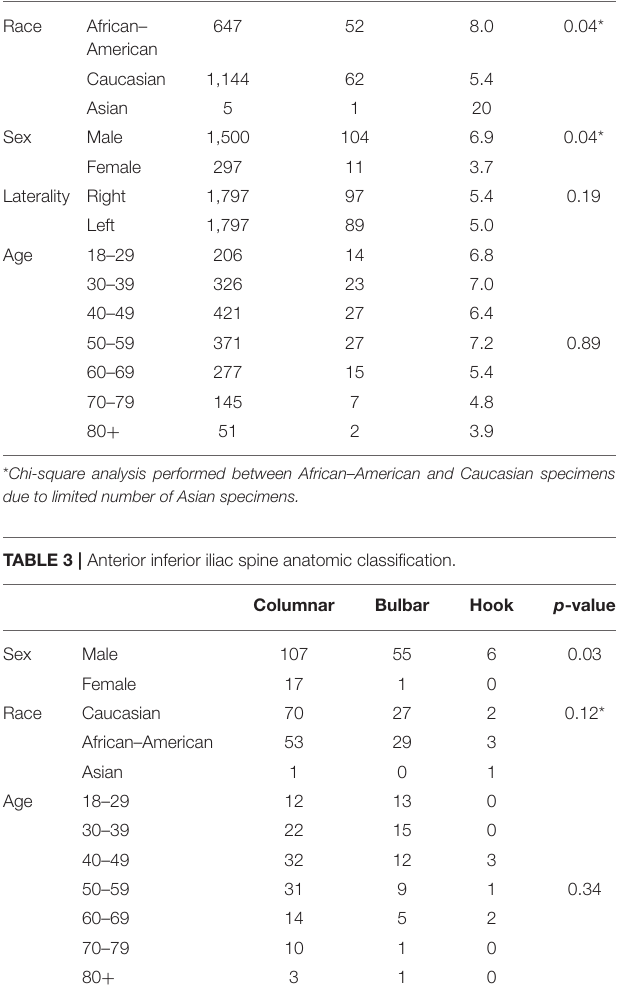
Number of Number of specimens specimens with AIIS dysmorphism